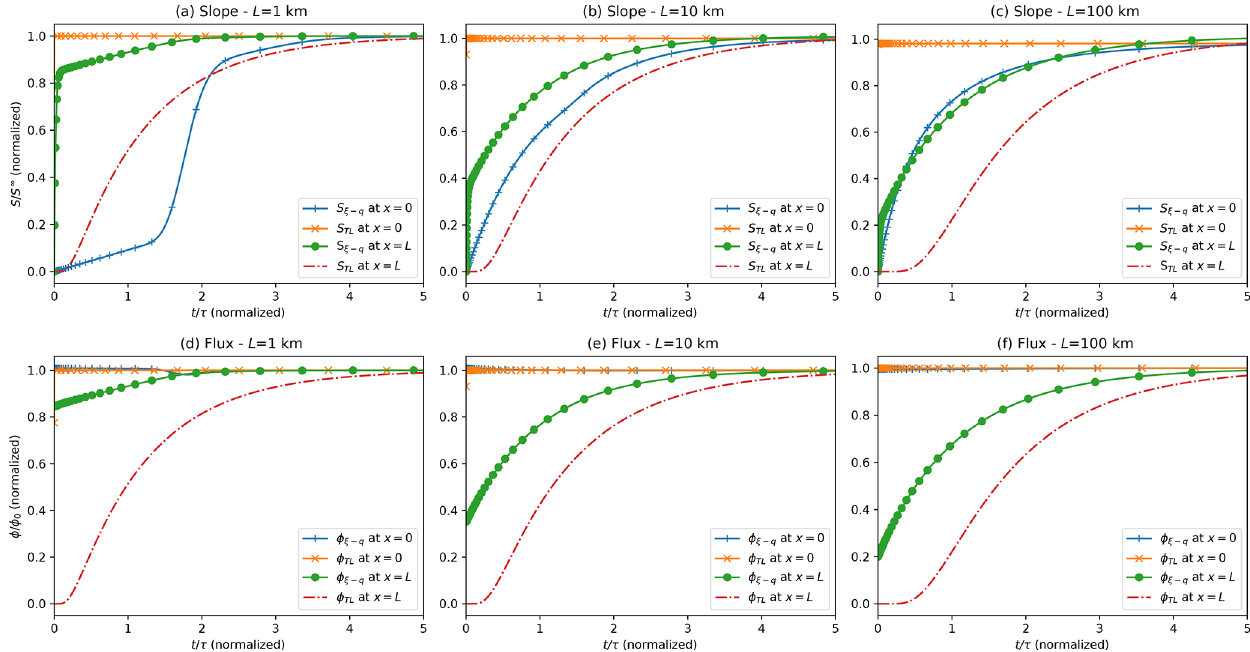
Figure 8. Evolution of the slope (a–c) and flux (d–f) normalized by their steady-state values at both ends of the system as a function of